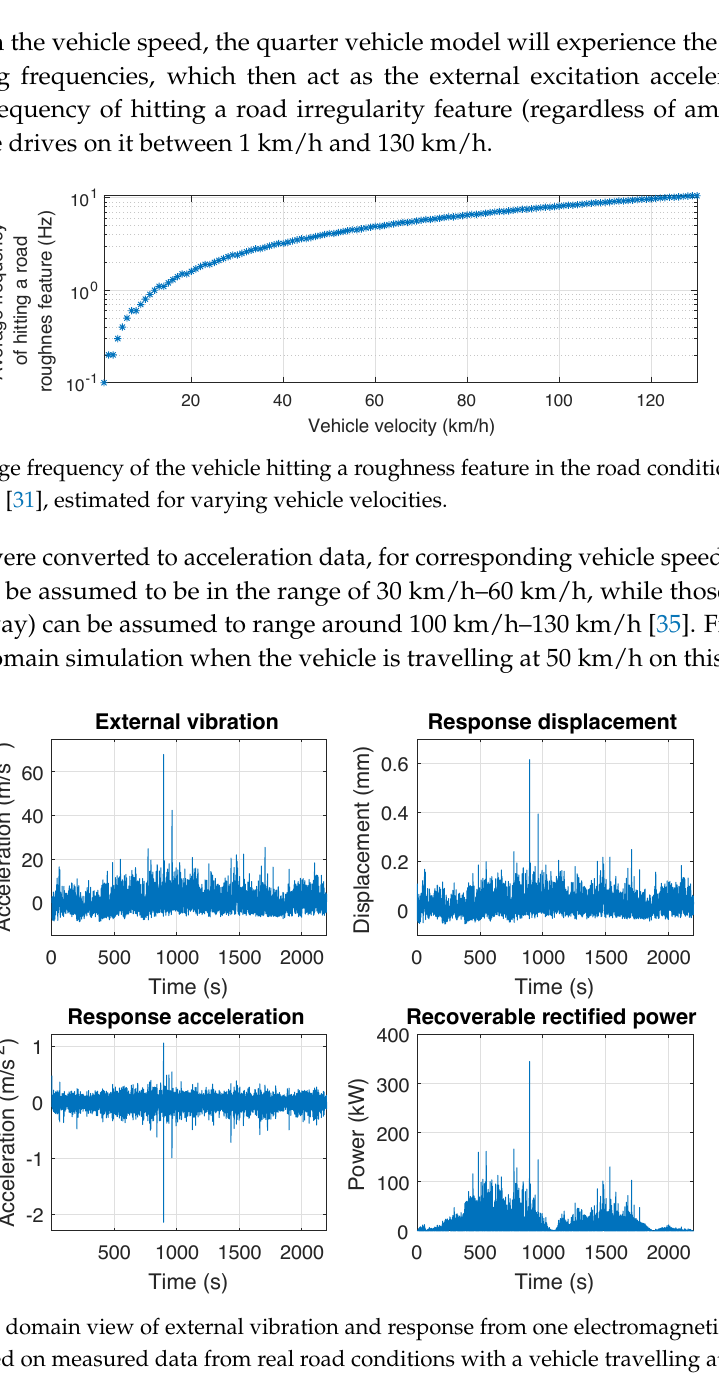
Figure 8. View of measured road condition data of an Australian road represented in the format of the International Roughness Index (IRI) [31]. The average IRI for this road is 2.79 m/km.